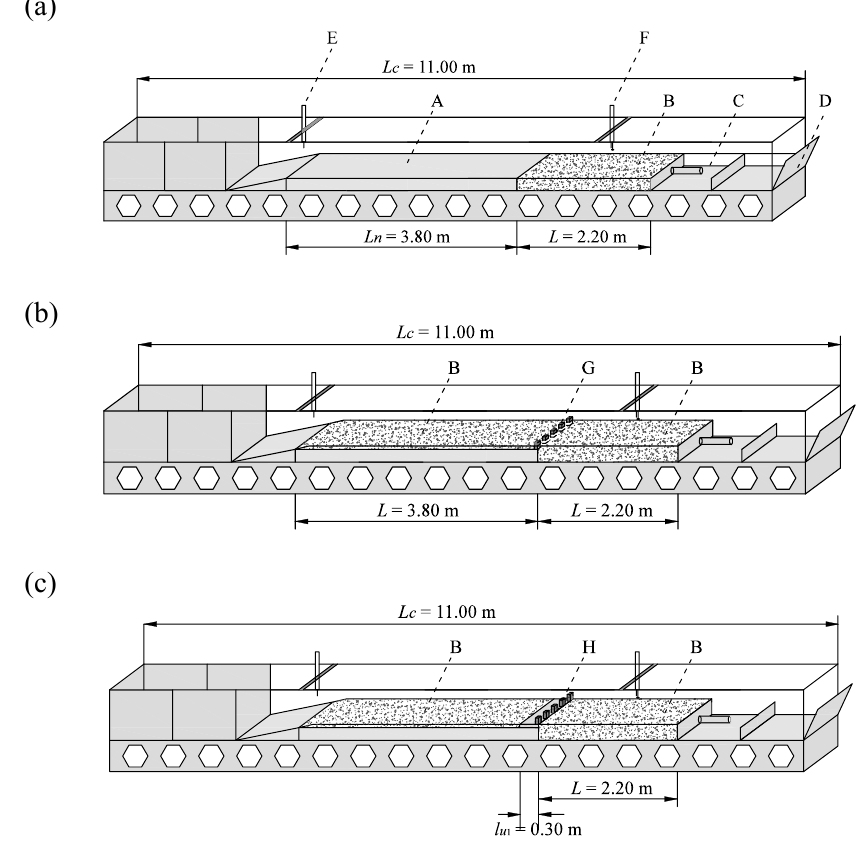
Figure 5. Flume development schematics. Variants: ( a ) I, ( b ) II, ( c ) III, where: A—solid bottom, B—